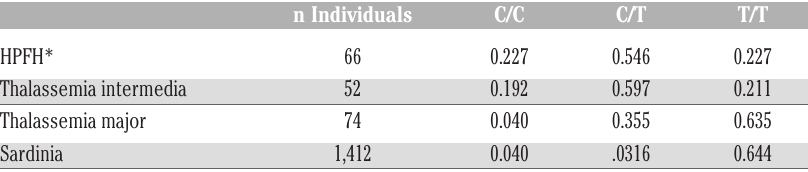
Table 2. Distribution of rs11886868 genotypes in thalassemic patients, HPFH individu- als, and the general population from Ogliastra (Sardinia).